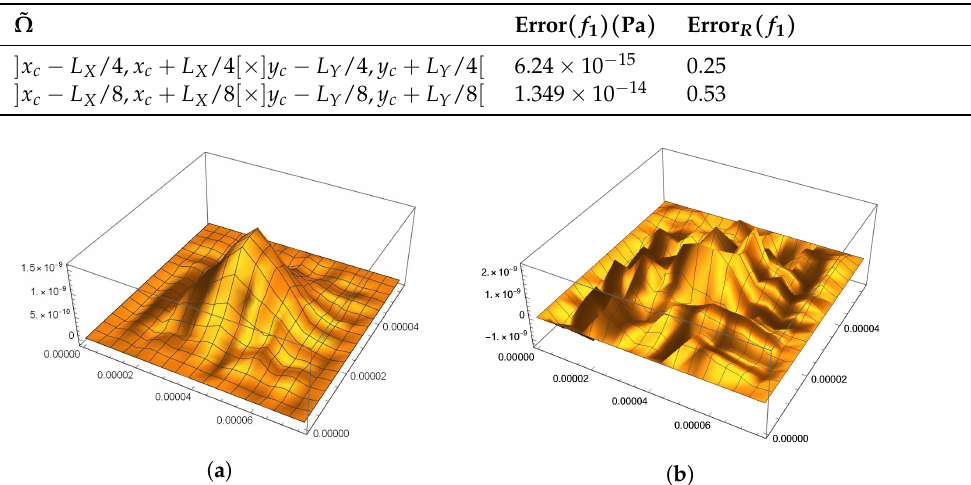
Figure 6. Comparison of the reconstruction results when we vary the size of the observation set ˜ Ω . ( a ) ˜ Ω =] x c − L X /4, x c + L X /4 [ × ] y c − L X /4, y c + L X /4 [ . ( b ) L X /8, y c + L X /8 [ . Table 2. Absolute and relative errors. Influence of the size of the observation set.